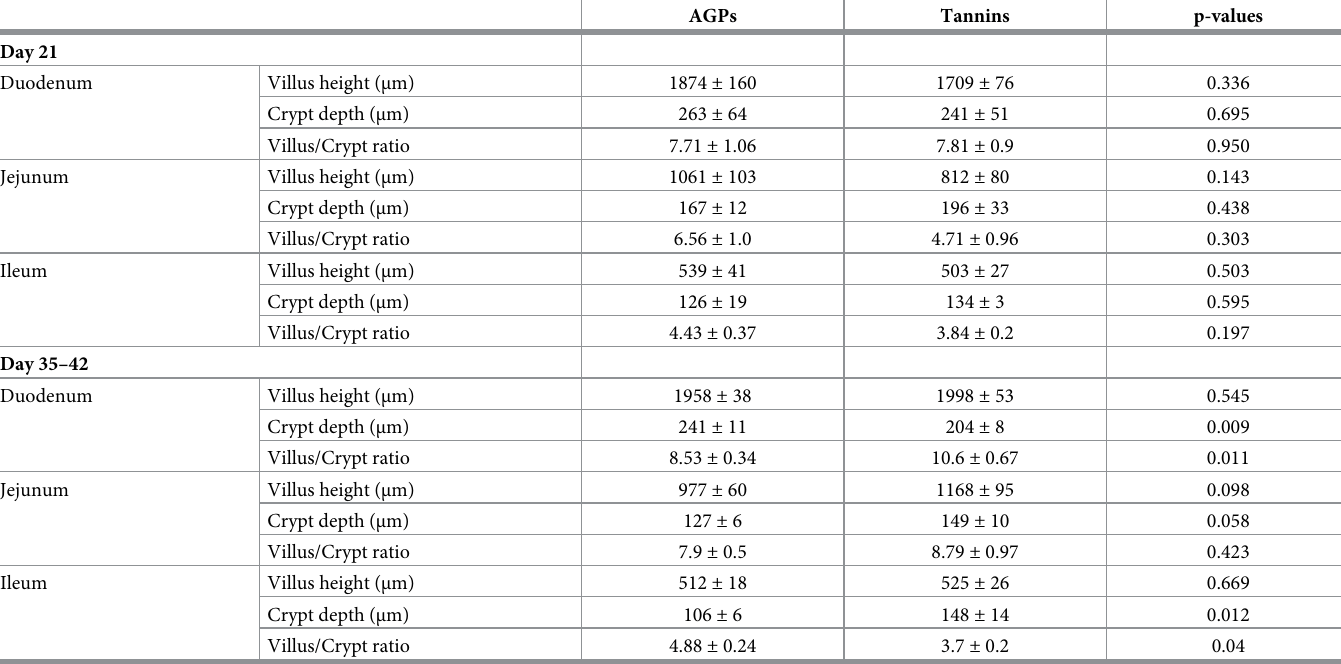
Table 3. Intestinal histomorphometry (Experiment 1).